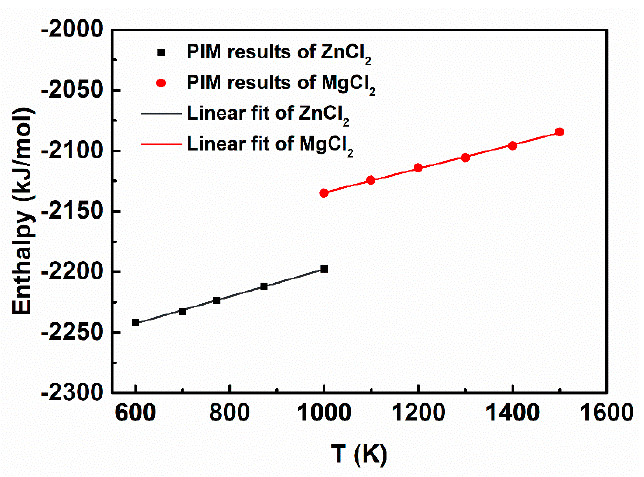
Figure 6. Enthalpies of MgCl 2 and ZnCl 2 with temperature in PIM. Table 7. Heat capacities of molten chloride salts in experiment and simulation